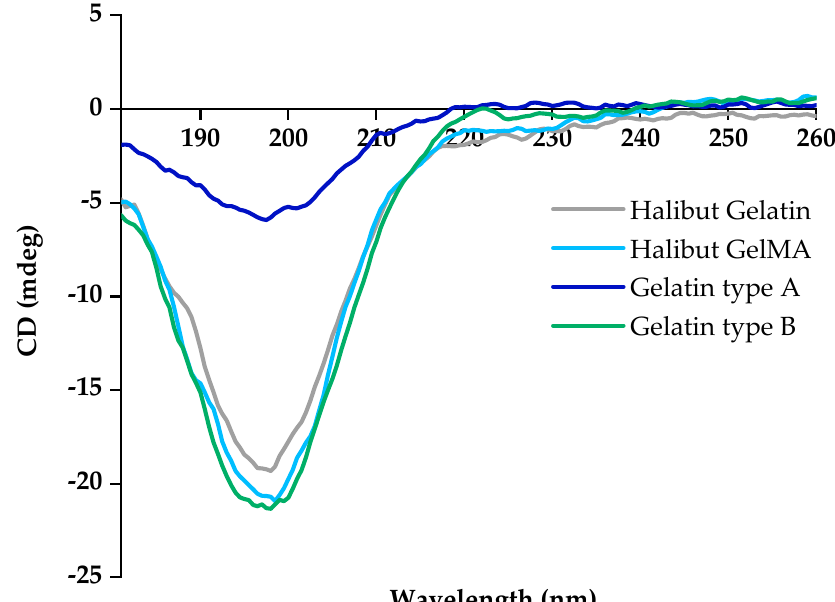
Figure 3. CD spectra of Greenland halibut skin gelatin (gray line), derived GelMA (light blue line), commercial gelatin type A (dark blue line) and commercial gelatin type B (green line).